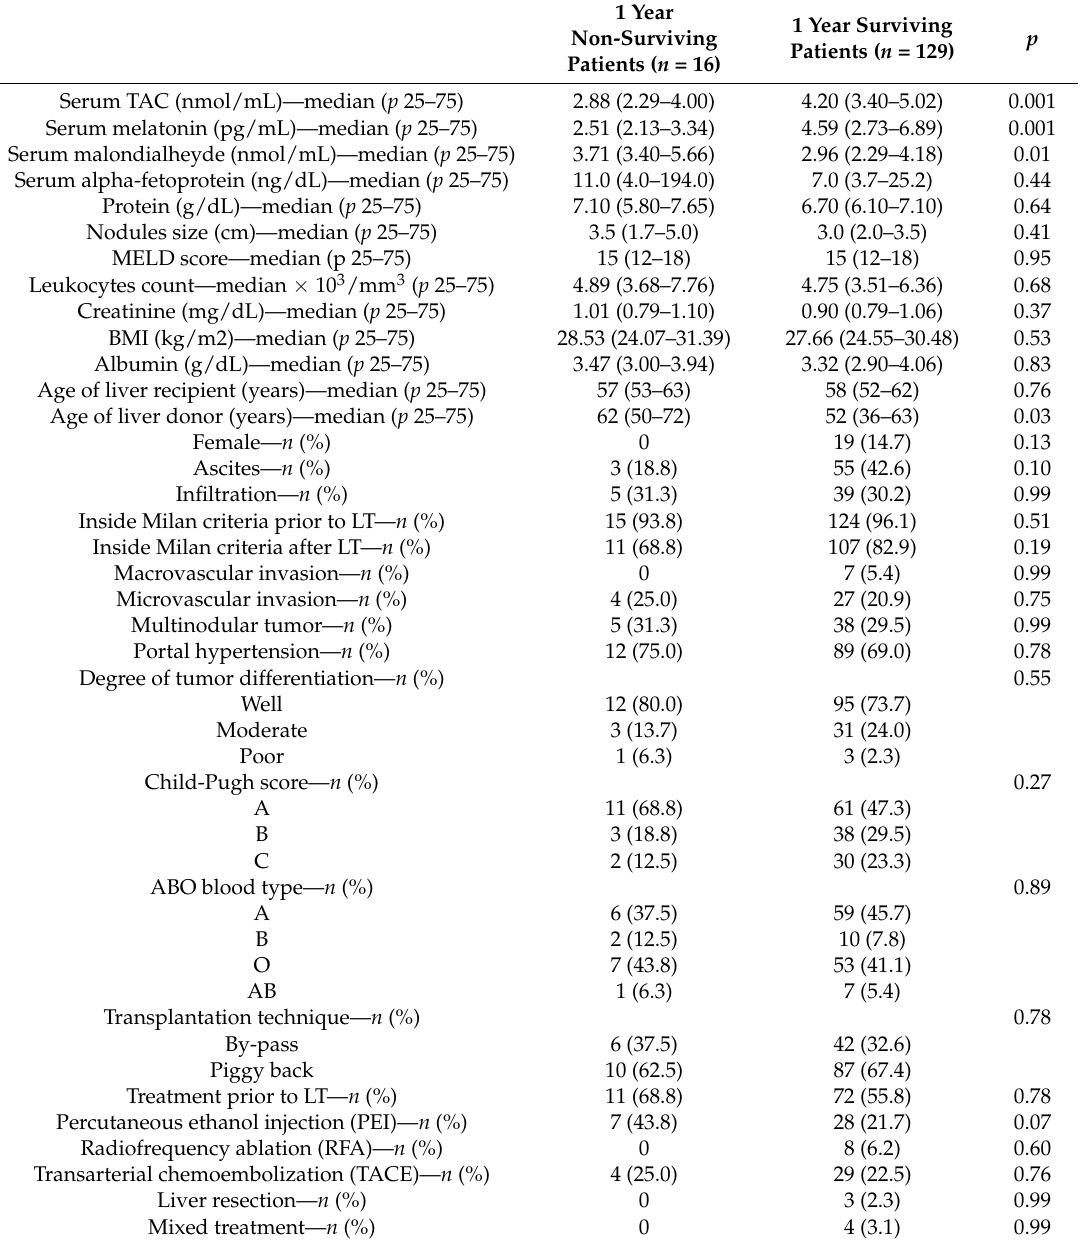
Table 1. Clinical characteristics of one-year liver transplantation surviving and non-surviving patients.